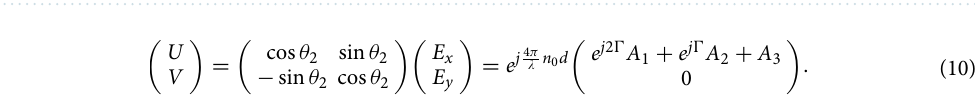
Figure 2. ( a ) Schematics of the single pixel of the proposed dual-layer IPS-LC SLM (upper panel) and its first and second IPS-LC layers (lower panel). ( b ) Simulated complex light modulation range of the dual-layer IPS-LC SLM. The red circle indicates the amplitude of